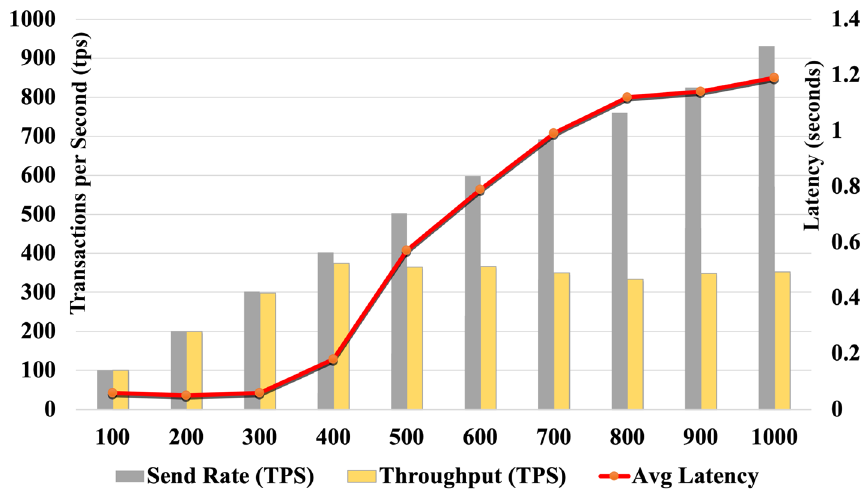
Fig. 15 Algorithm 2 performance: processing received metrics at variable rates and fixed total of 1000